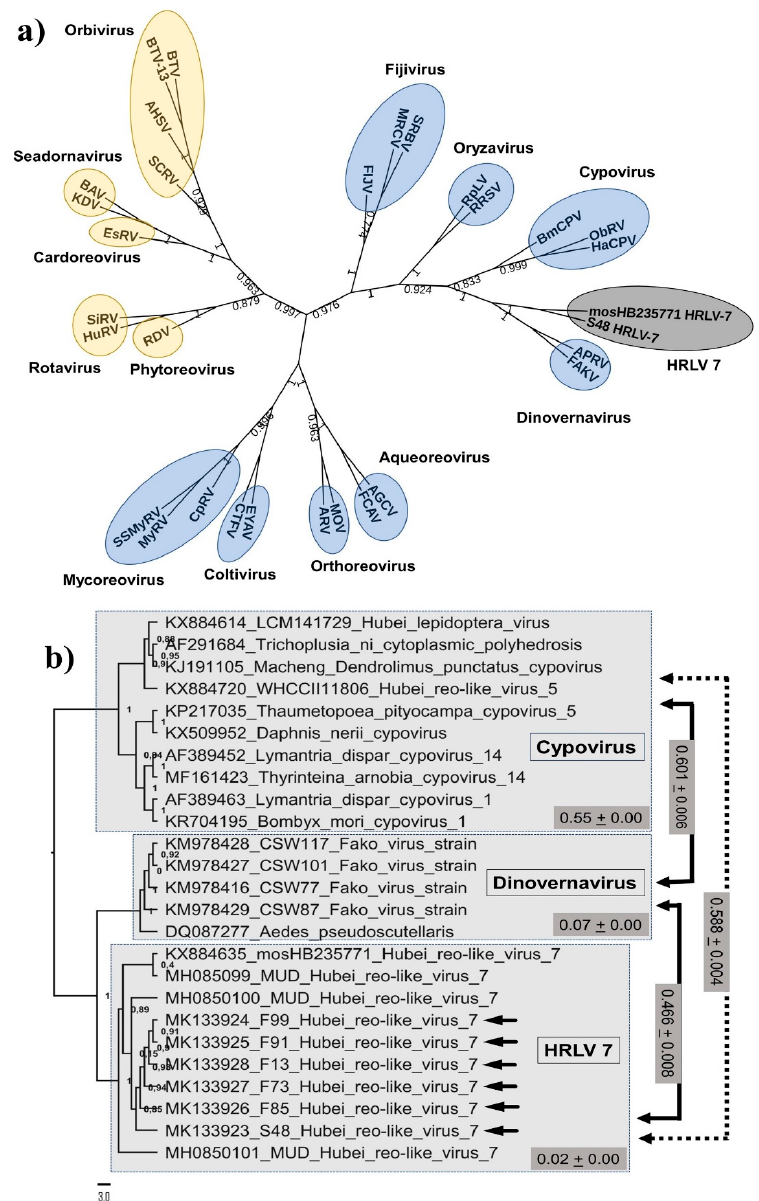
Figure 2. Phylogenetic trees constructed with the RdRp gene region of reoviruses. ( a ) Phylogeny of representative reovirus sequences based on the alignment of full-length protein sequences of RdRp. HRLV 7 strains are highlighted in the gray circle. Members of the subfamily Spinareovirinae are highlighted in blue, and members of the subfamily Sedoreovirinae are highlighted in yellow. The various genera are also indicated in bold. Tip labels include the International Committee on Taxonomy of Viruses (ICTV) abbreviations. This tree was constructed using the Neighbor-Joining method and assuming a JTT model [24]. Values on the node of the trees indicate the statistical support based on a bootstrap test using 1000 replicates. Sequences used for phylogenetic analyses are shown in Supplementary Table S1. ( b ) Maximum likelihood (ML) tree based on nearly full-length of nucleotide sequences of RNA-dependent RNA polymerases (RdRp) shows three groups (gray areas) containing strains from Dinovernavirus , Cypovirus and HRLV 7 strains. The Brazilian strains described in this work are indicated by arrows. The filled gray rectangle indicates genetic distance within and between the clades. The ML tree was inferred using the General Time Reversible (GTR) + gamma distribution model and values on node of the trees indicate the statistical support based on the approximate likelihood ratio test